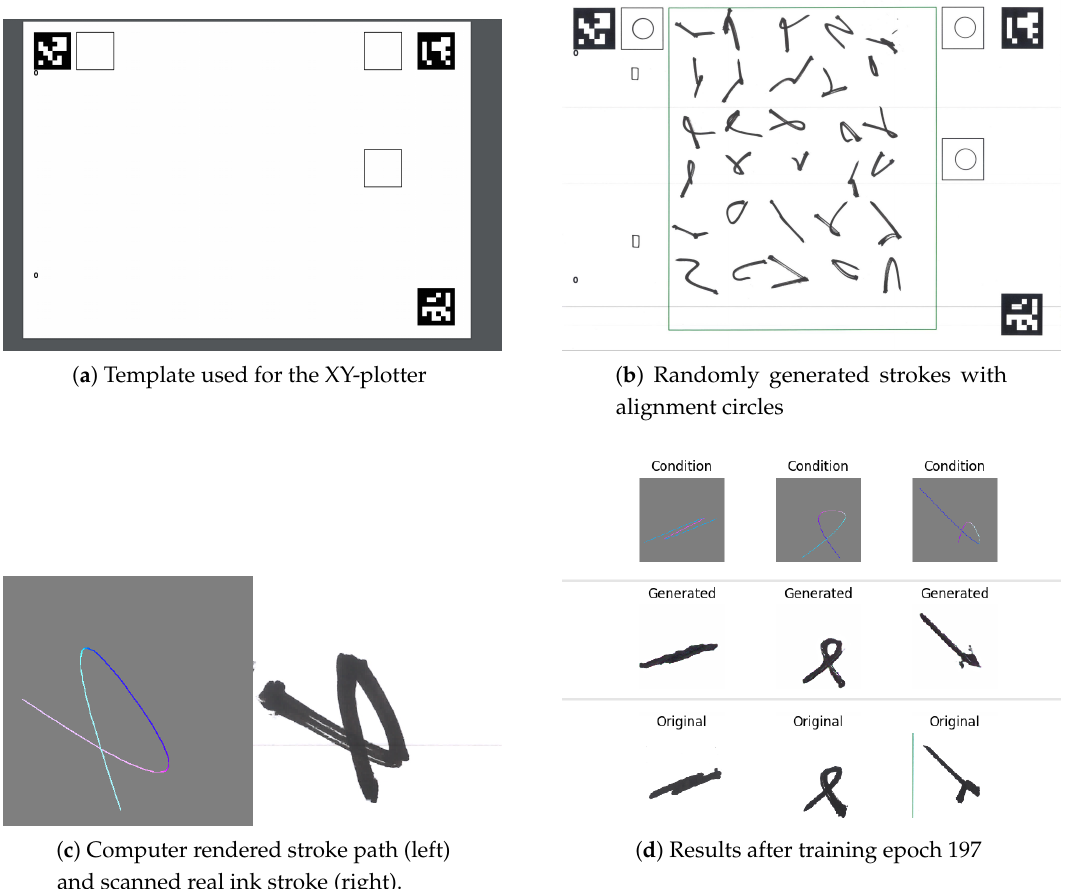
Figure 8. Using pix2pix to predict stroke outcomes from